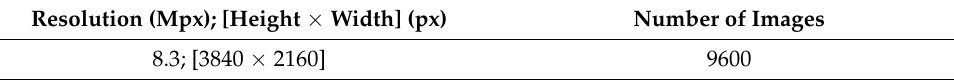
Table 2. Specifications of the training dataset for the classification of tiles.